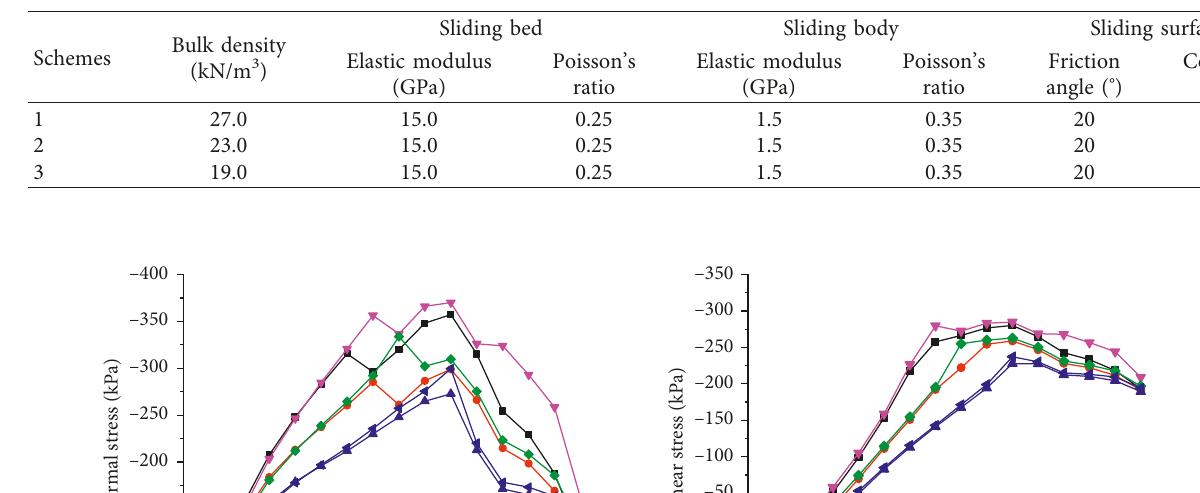
Table 11: Calculation schemes for influence of excavation stress release on slope stability.